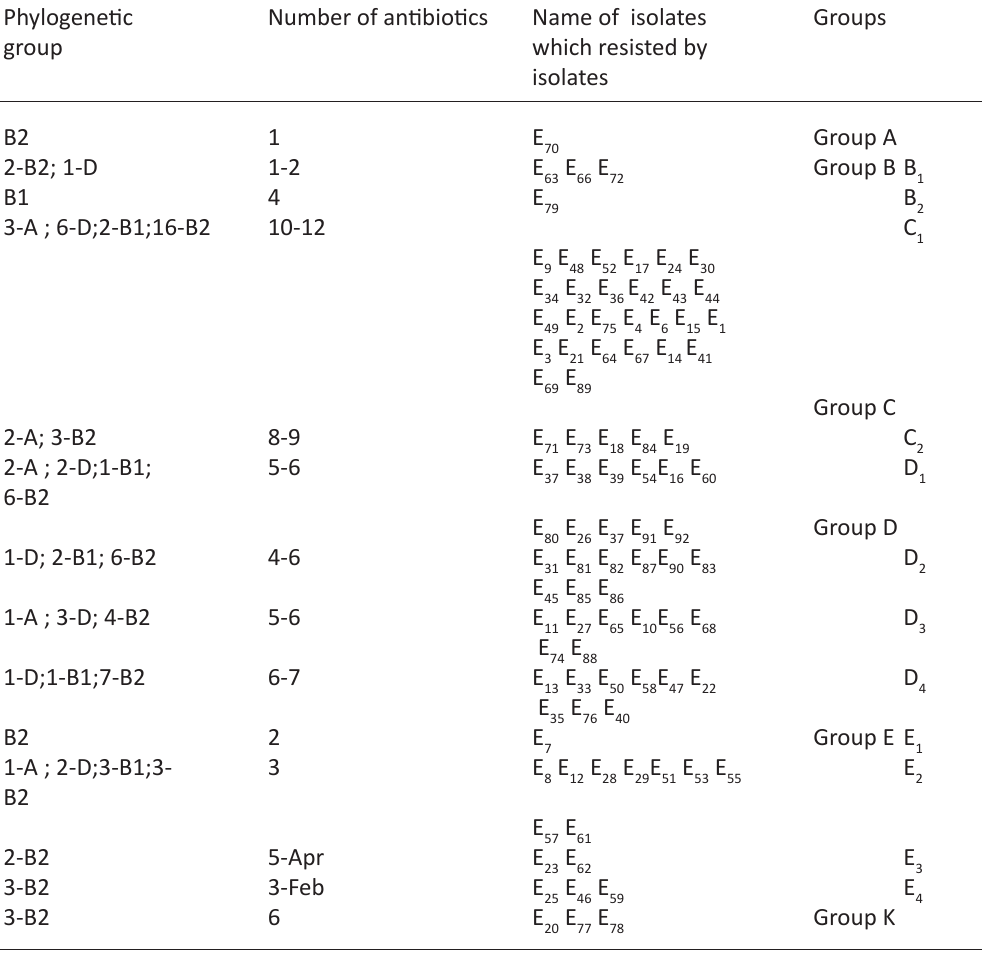
Table 3. Distribution of E. coli phylogenetic group according to antibiogram profiles dendrogram analysis